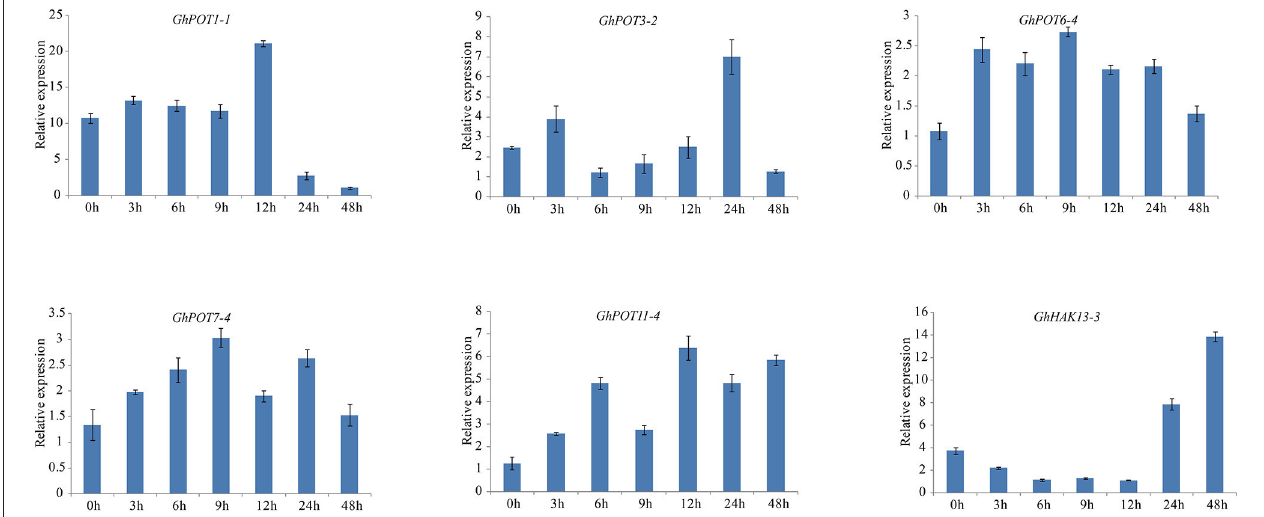
FIGURE 10 | Expressions of GhPOT genes in response to salt stress (300mM NaCl). The expressions of the GhPOT genes were determined by qRT-PCR using the total RNA isolated from TM-1 leaves at different time points (0, 3, 6, 9, 12, 24 and 48h) of potassium deficiency stress. The error bars indicate the standard error (SE) of three biological